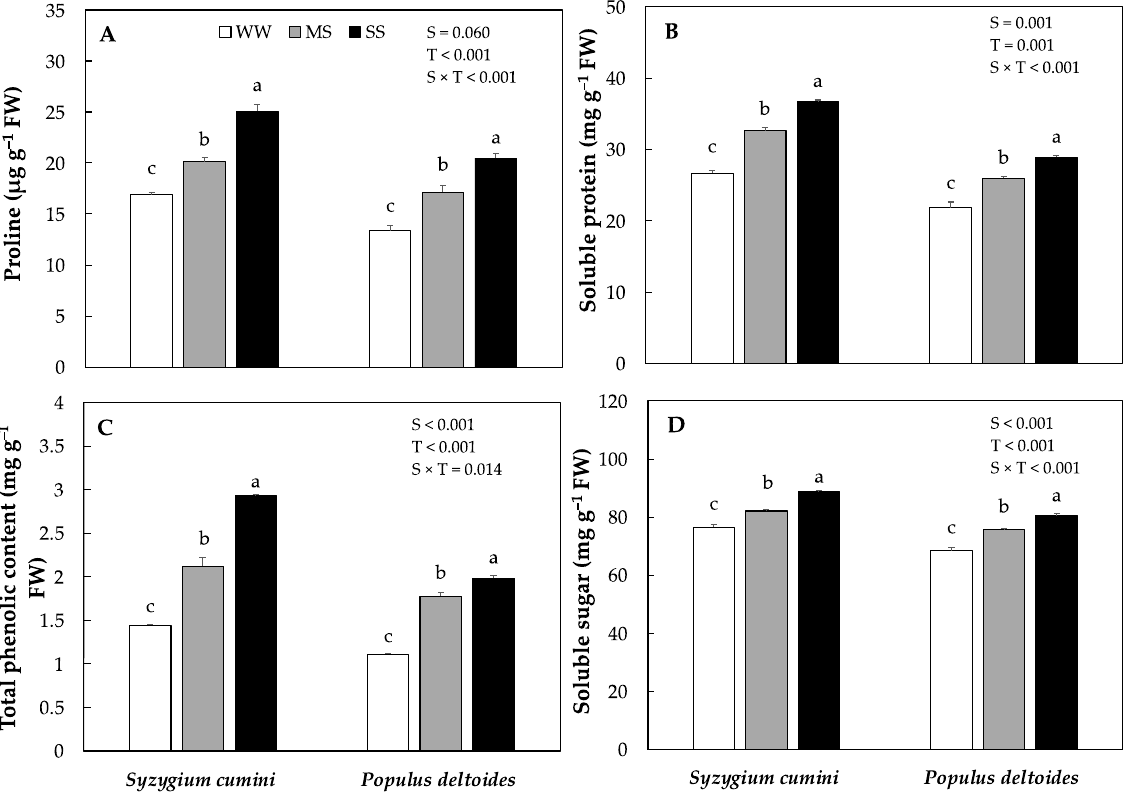
Figure 2. Means of various concentration of Osmolytes ( A ) proline, ( B ) soluble protein, ( C ) total phenolic content and ( D ) soluble sugar under various level of water deficit treatments in Syzygium cumini and Populus deltoides . The traits were tested using a two ‐ way ANOVA for species effect (S ‐ effects), treatment effect (T ‐ effects) and interaction effects (S × T). Values represent the means (±SE) in various treatments. Small letters represent significant difference between treatments within each species tested using the Dunnett’s test. All tests were taken to be significant at p < 0.05.